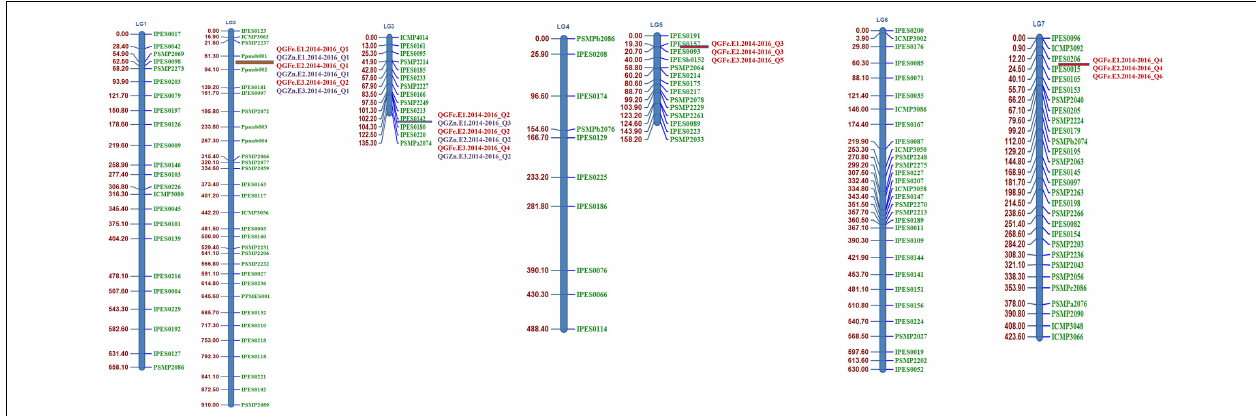
FIGURE 2 | Linkage map (linkage groups LG 1–LG 7) of the pearl millet recombinant inbred line (RIL) population based on the cross (PPMI 683 × PPMI 627). QTL identified in red color font indicates the grain Fe QTLs and QTL identified in blue color font indicates the grain Zn QTLs. TABLE 7 | Details of the simple sequence repeats (SSRs)-based linkage map of the pearl millet RIL population based on the cross PPMI 683 × PPMI 627. Linkage group SSR marker loci Skewed SSRS Total marker loci Skewed loci